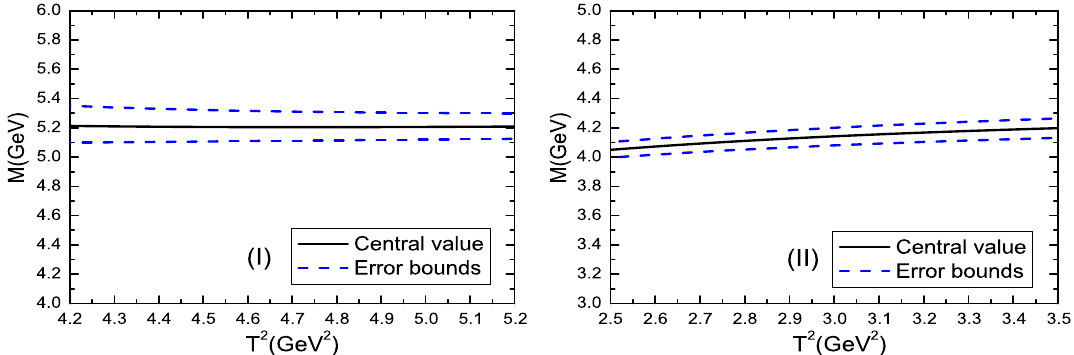
Fig. 1 The masses of the axialvector tetraquark states with variations of the Borel parameters T 2 , where the (I) and (II) correspond to the currents J 1 μ ( x ) and J 2 μ ( x ) , respectively